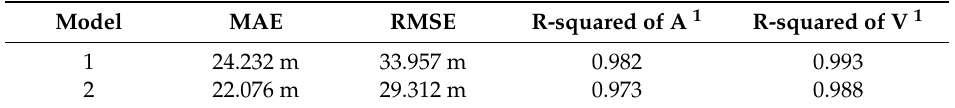
Table 2. Statistical analysis result of Lake